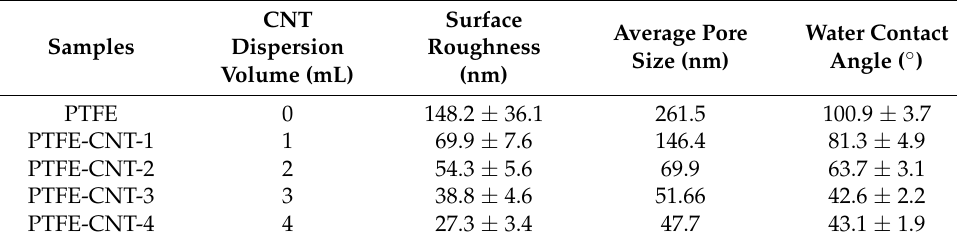
Table 2. Structure and properties of the Pristine PTFE and the PTFE-CNT Membrane.